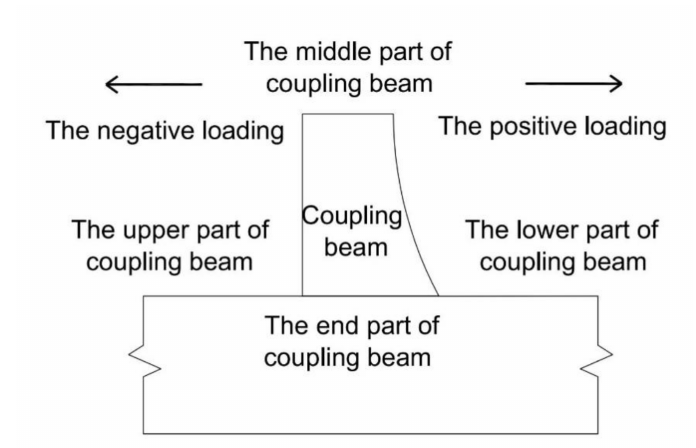
Figure 12. The position and loading direction of the specimen.